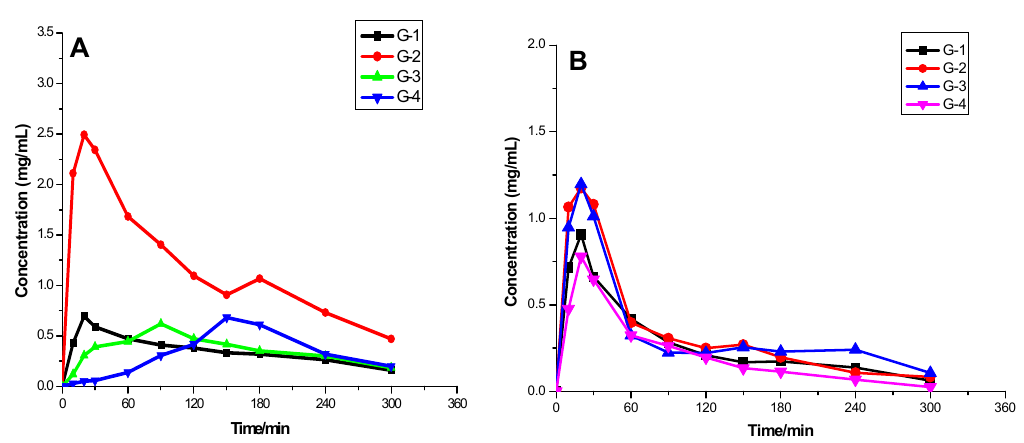
Figure 6. The plasma concentration-time curves of puerarin and daidzin after rabbit stomachs were perfused with four kind of GGD with dosages equal of 0.82 g/kg ( n = 4, x ˘ sd ). ( A ) The plasma concentration-time curves of puerarin; ( B ) mean plasma concentration-time curves of daidzin. After rabbit stomachs were perfused with GGD, puerarin and daidzin was rapidly absorbed into Table 1. Pharmacokinetic parameters of puerarin after rabbit stomachs were perfused with four kinds the blood. The half-life times for elimination (t 1/2 α ) of G-1, and G-2 were 5.15 ± 2.01 min, 17.79 ± 9.82 min, of GGD of dosage equal to 0.82 g/kg ( n = 4, x ˘ sd ) R . respectively, whereas the half-life elimination (t 1/2 β ) times of G-3, G-4 were 69.32 ± 3.58 min, 65.28 ± 4.93 min, respectively, indicating that puerarin was relatively quickly eliminated from plasma with a short elimination half-life in the G-1, G-2 groups. The maximum plasma drug concentrations (C max )